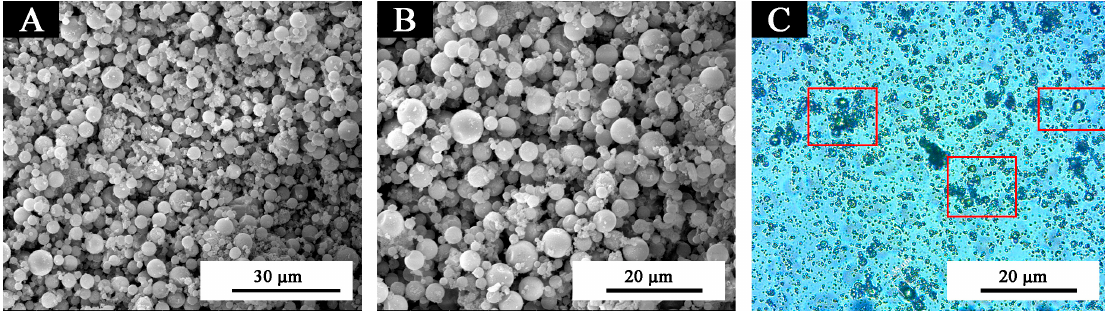
Figure 3. Morphology of thermochromic microcapsules: SEM of ( A ) low magnification and ( B ) high magnification, ( C ) OM of thermochromic microcapsules with light diffraction ring phenomenon.